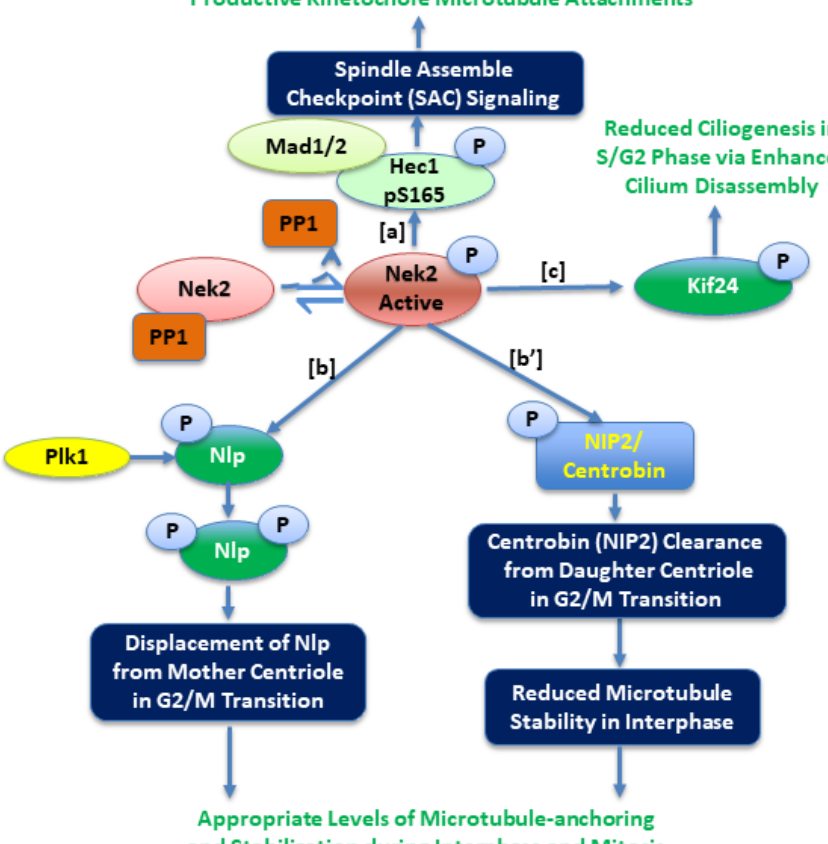
Figure 3. The role of Nek2 kinase in spindle assembly checkpoint (SAC) signaling, microtubule dy- namics during G2/M transition, and ciliogenesis: (a) Nek2 phosphorylates Hec1 at Ser165, preferen- tially at the kinetochores during SAC. Hec1-pS165 then recruits and interacts with MAD1 protein to promote SAC signaling on misaligned chromosomes lacking proper microtubule attachment. (b, b’) During G2/M transition, Nek2 kinase also regulates (via phosphorylation) the displacement of (i) mother centriole component protein, Nlp, and (ii) daughter centriole component protein centrobin (NIP2). This leads to appropriate levels of microtubule anchoring and stabilization during inter- phase and mitosis. (c) Nek2 kinase activates microtubule depolymerizing kinesin protein, Kif24, via direct phosphorylation and negatively regulates ciliogenesis in proliferating cells.